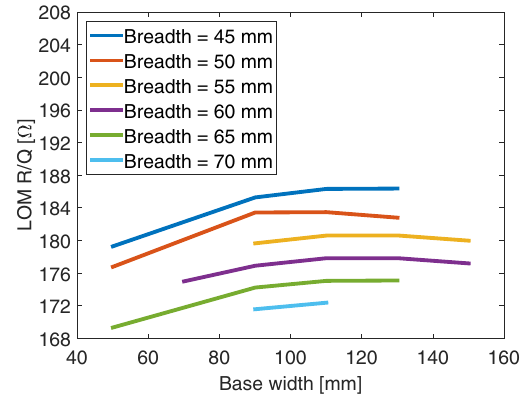
FIG. 10. R/Q of the LOM vs width for different values of breadth for the base ellipse with the tip width and breadth fixed at 45 mm and 40 mm,